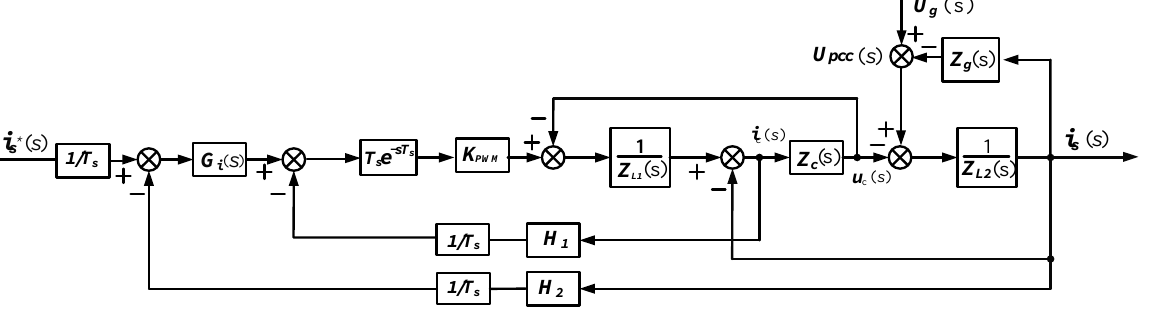
Figure 2. S-domain model of grid-connected current.